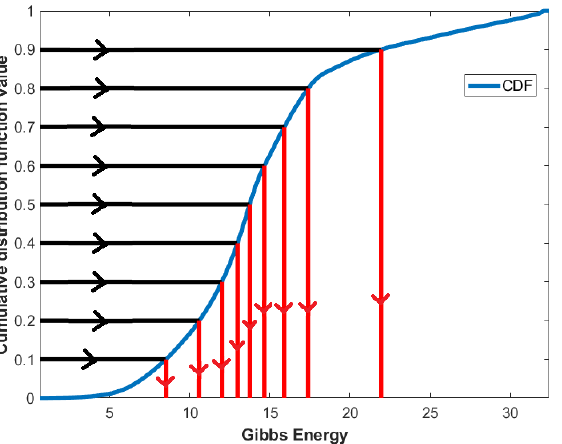
Figure 5. An illustrative example of the estimation of CDF percentile feature from